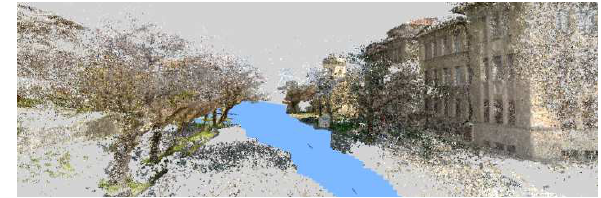
Figure 14. Camera positions estimated by Agisoft Photoscan Professional.